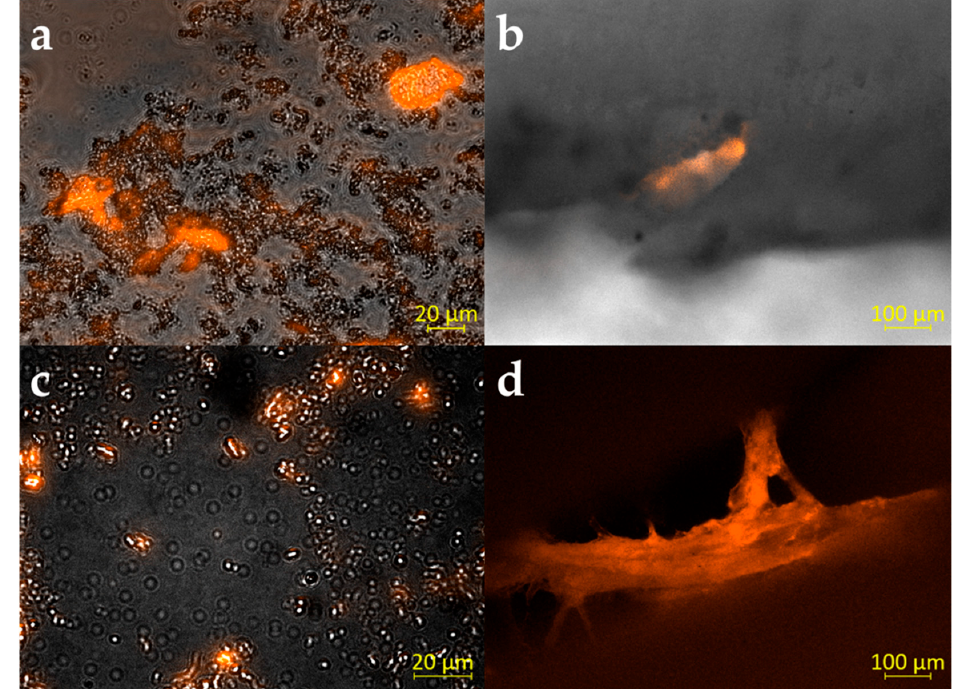
Figure 4. Microscopic imaging of biofilm formation. The extracellular polysaccharide matrix of biofilm-forming microorganisms was stained using EbbaBiolight680 after 5 ( a , b ) and 7 ( c , d ) days of incubation. Biofilm was either removed from the root canals before staining using toothpicks ( a , c ) or split teeth were analyzed ( b , d ). Panel b shows biofilm in a side channel and panel d shows biofilm attached to the root canal wall located at the bottom of the picture. ( a – c ) are overlays of brightfield and fluorescence, ( d ) show fluorescence in the red channel of the microscope only.